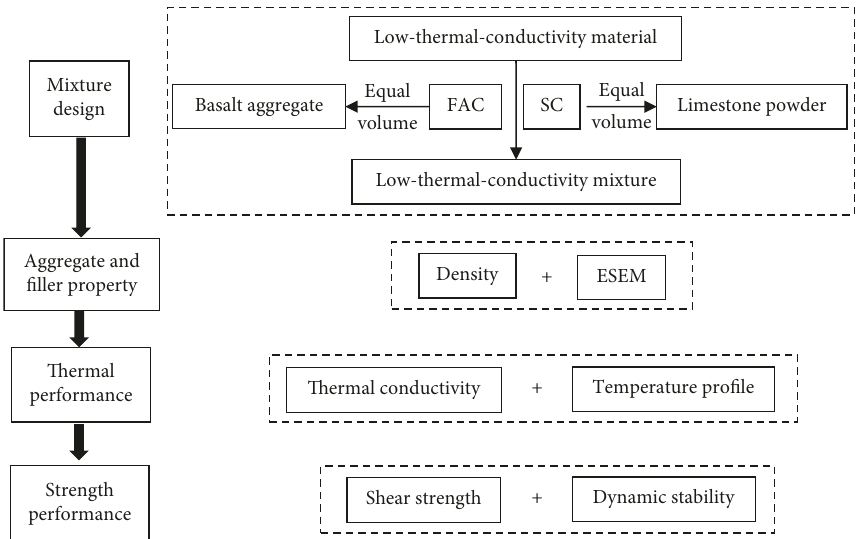
Figure 1: Flow chart of the process of mixture design and performance